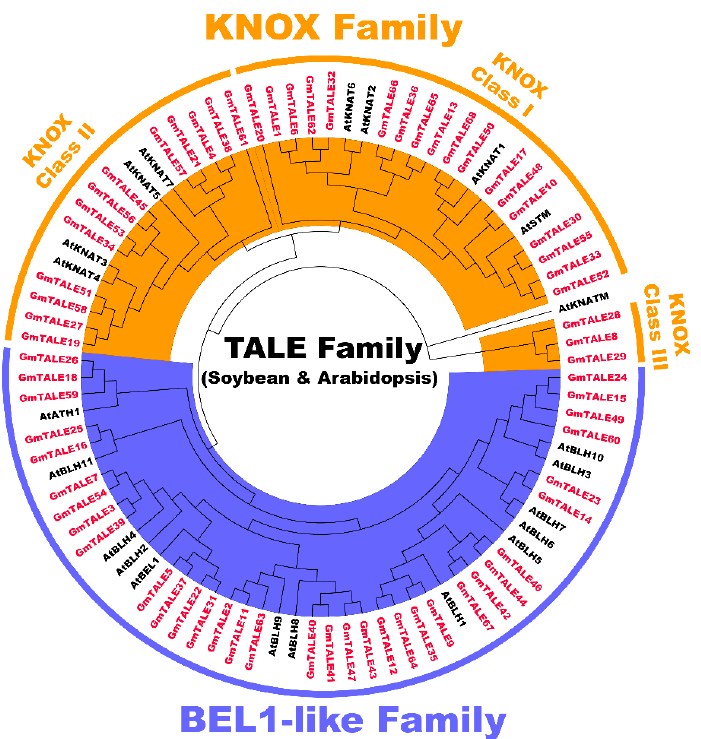
Figure 1. Unrooted phylogenetic tree of three-amino-acid-loop-extension (TALE) proteins in soybean and Arabidopsis . By using MEGA 7.0, the multiple protein sequences in two species were aligned with the MUSCLE method, and the tree was built used the maximum likelihood (ML) method with the best scoring JTT + G + I model. The tree was further categorized into the KNOX and BEL1-like subfamilies. All the GmTALE proteins have been emphasized in red.